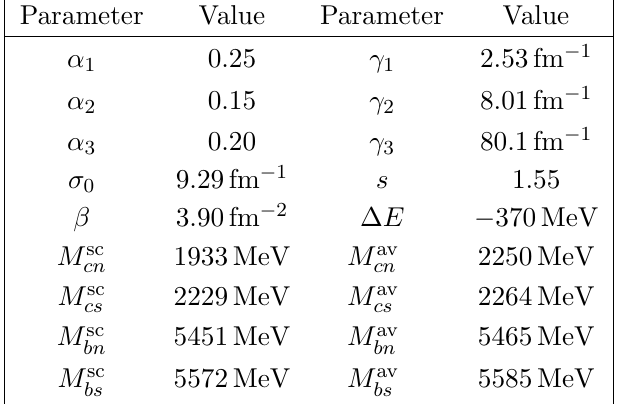
Table 6 . Parameters of the Hamiltonian (4.1). Here n = u or d and the superscripts \sc" and \av" indicate scalar and axial-vector diquarks,